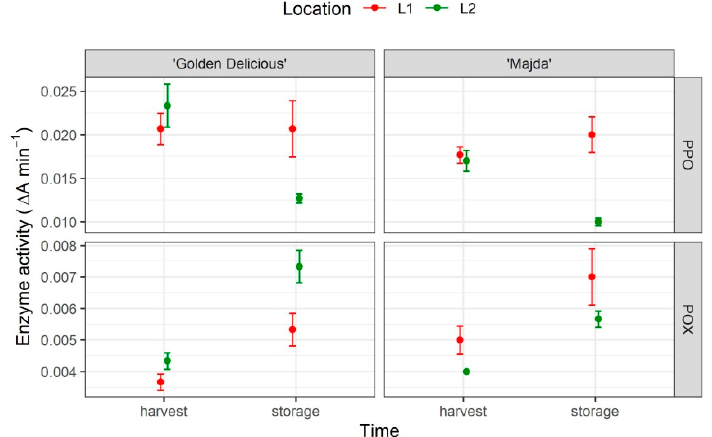
Figure 9. Activity of PPO and POX ( ∆ A min − 1 ) in apple flesh of cultivars ‘Golden Delicious’ and ‘Majda’ at harvest and following storage.